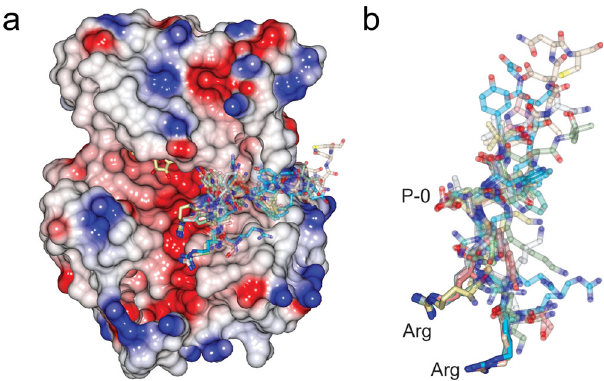
Fig. 6 Comparison of PAK4 complexes. Superposition of PAK4 structures in complex with integrin β 5 (7S46, 7S47, and 7S48), consensus peptide (2Q0N), PAKtide-S (4JDI) 47 , autoinhibitory pseudosubstrate (4FII) 25 , N-terminal polybasic region (5UPK) 27 , (Inka inhibitory pseudosubstrate (4XBU) 30 , LIMK1 substrate peptide (6WLY) 48 and β -catenin substrate peptide (6WLX) 48 . a Electrostatic surface of PAKtide-S bound PAK4, sticks for bound AMP-PNP, and stick format peptides for each structure, when kinase domains are superposed on their C-lobes. b Close-up of the peptides, illustrating the similarity of location for the basic charged arginine residues. Phosphoacceptor site indicated as